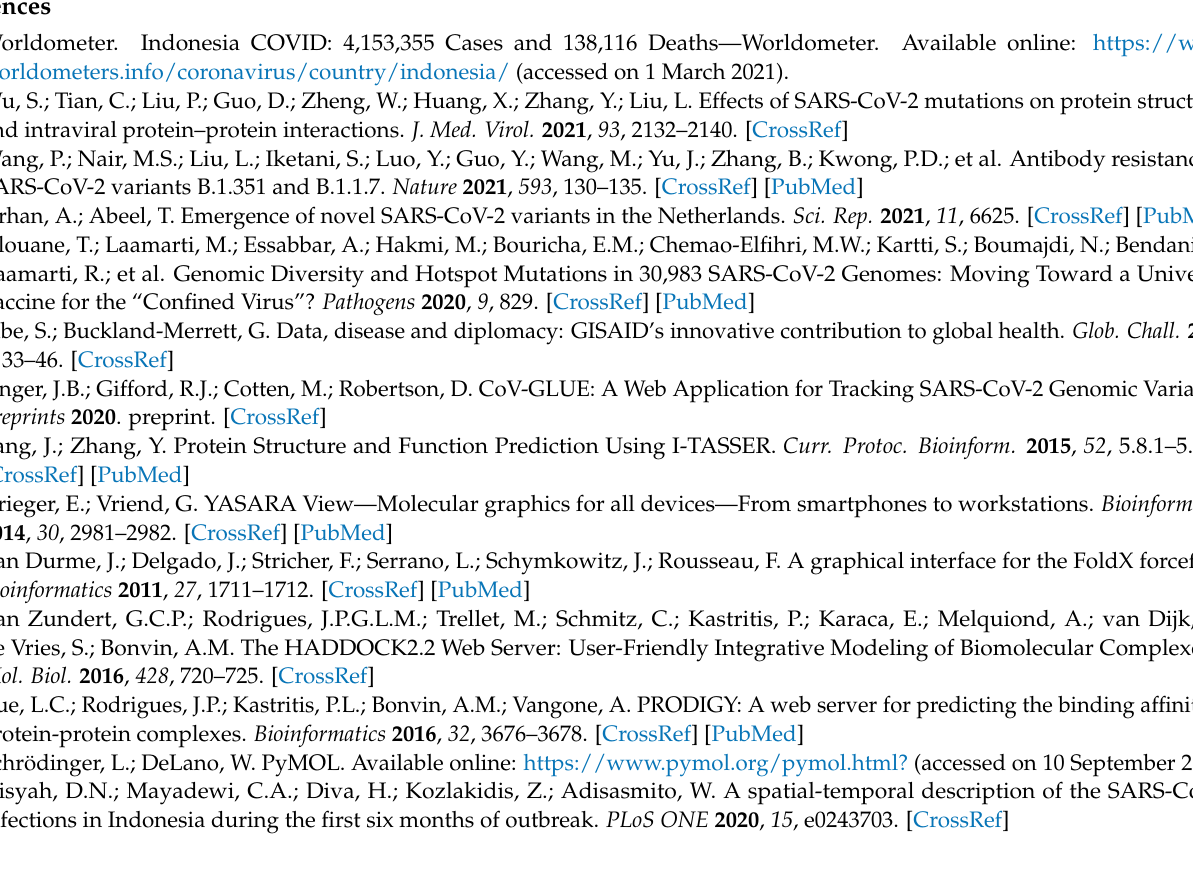
Table S4: Molecular docking analysis of spike protein (wildtype, B.1.466.2, B.1.470 and B.1.617.2 variant) with ACE2 receptor. Figure S1: Kruskal–Wallis test for the significance of mutation rate of three dominant SARS-CoV-2 variants. Mutation rate of the B.1.617.2 Delta variant is significantly higher than the other two dominant variants (tested using the Kruskal–Wallis test, with p < 0.05). Figure S2: Visualization of interaction between spike protein of B.1.466.2, B.1.470, and B.1.617.2 variant with ACE2 receptor along with position of mutated residues show in red